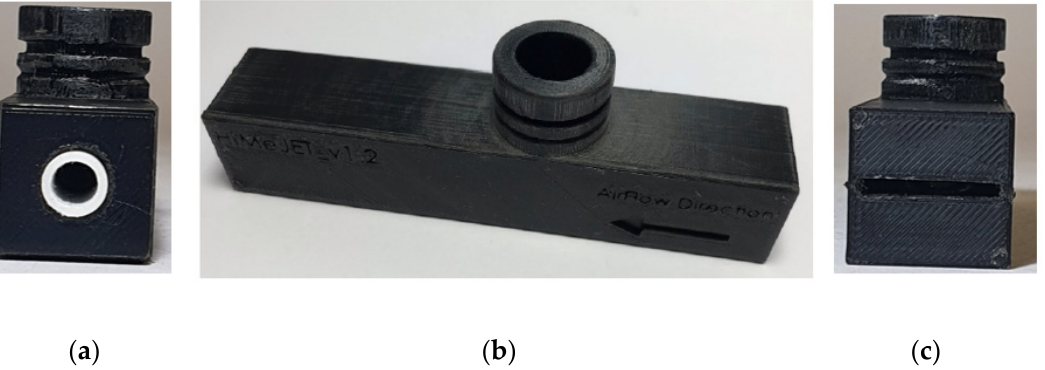
Figure 2. Novel air-texturing nozzle produced with additive manufacturing technique: ( a ) feed section, ( b ) main module and ( c ) delivery section.